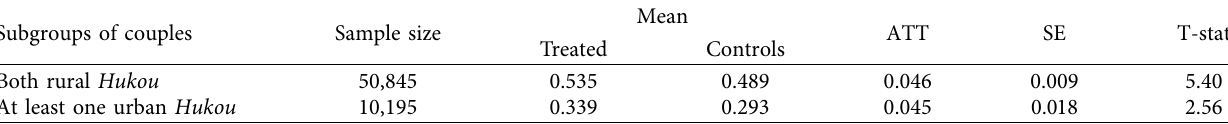
Table 8: ATTestimates for subgroups of couples: the treatment effect of having grandparents as the primary-care provider for the first child on having the second birth.